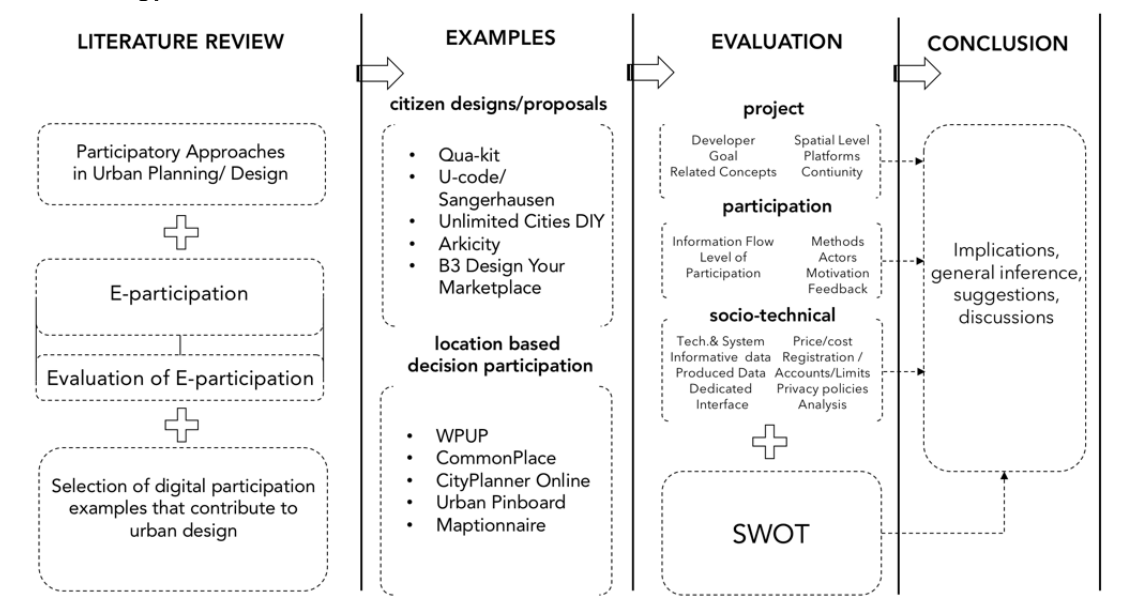
Figure 1. Structure of the